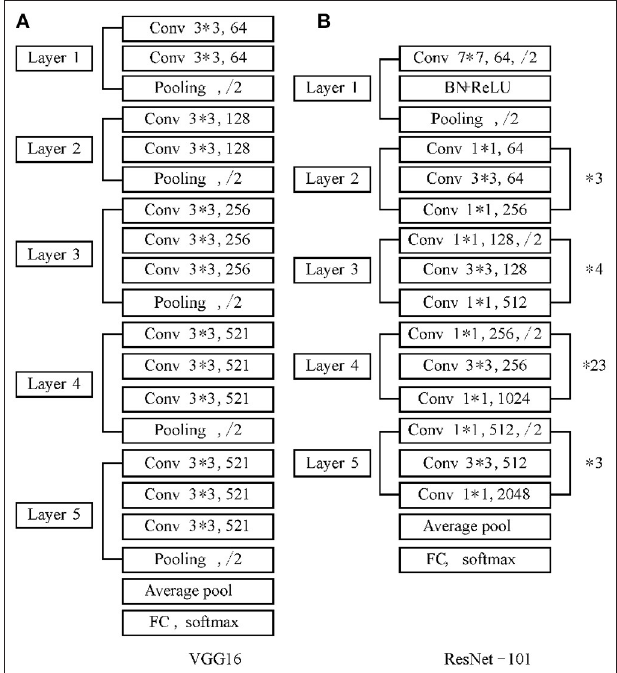
FIGURE 1 | VGG-16 and ResNet-101 network